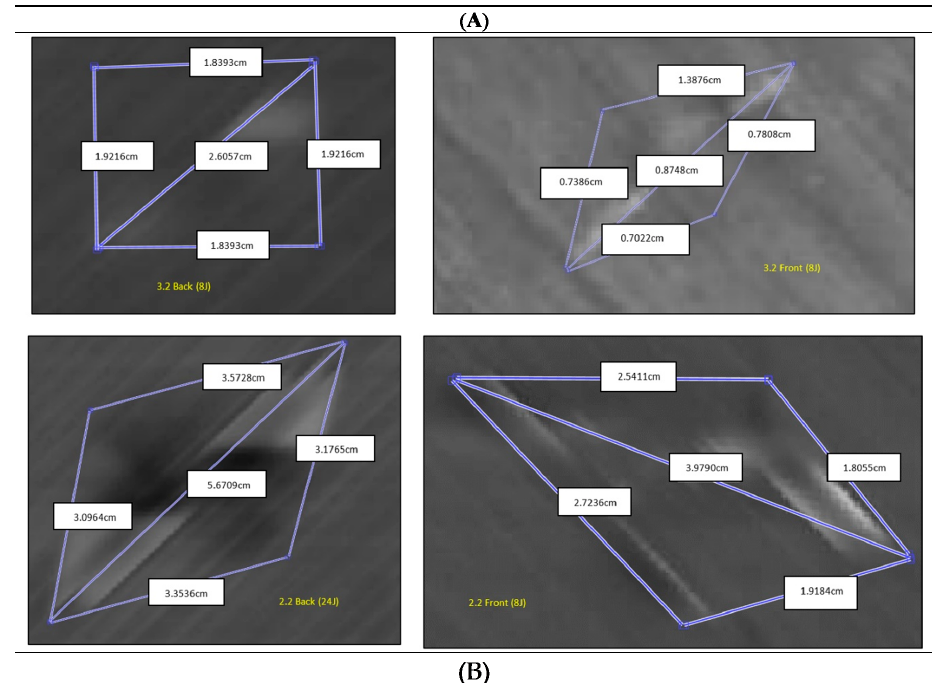
Figure 14. ( A ) All Active thermographic data from raw to post-processed data. ( B ) Enlarged images outlining the defects and displaying the size in both samples.